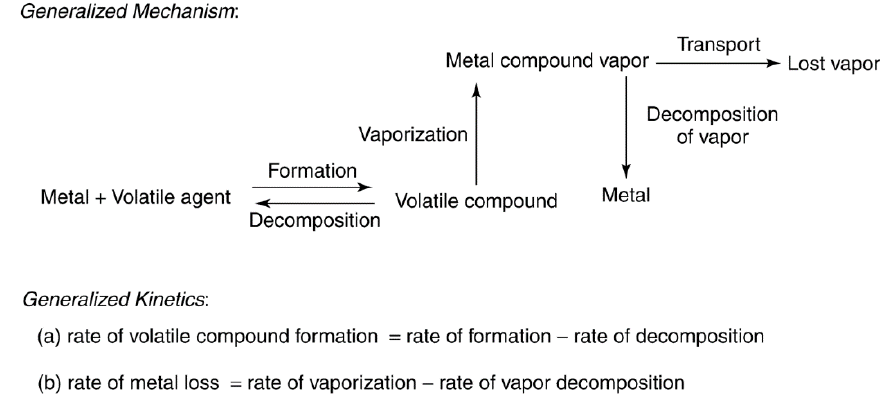
Figure 22. Generalized mechanisms and kinetics for deactivation by metal loss.